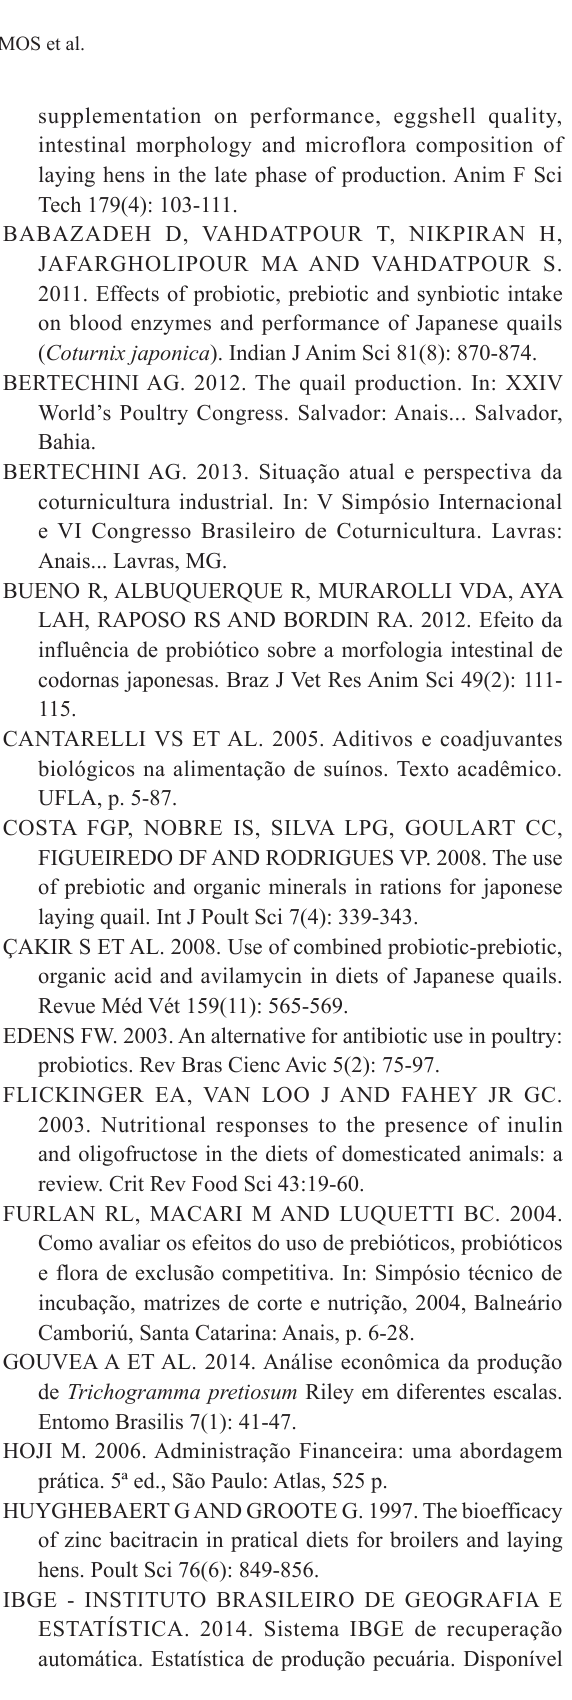
FIGUEIREDO DF AND RODRIGUES VP. 2008. The use of prebiotic and organic minerals in rations for